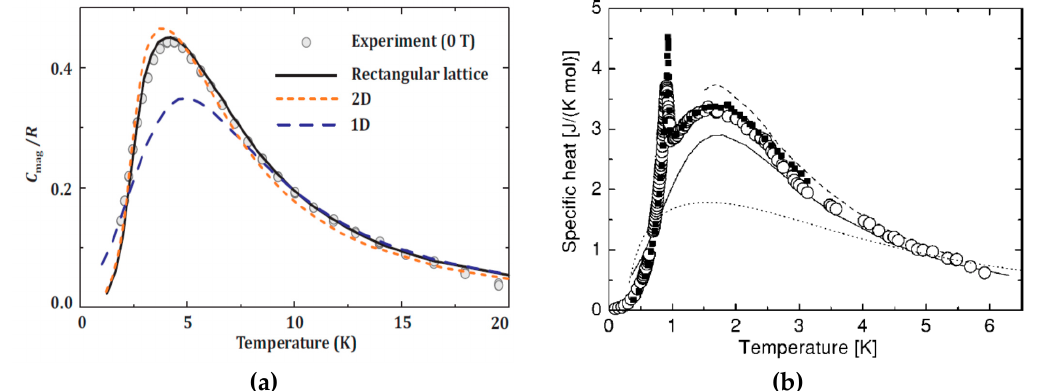
Figure 6. ( a ) Fits of the magnetic specific heat of Cu(PM)(EA) 2 in B = 0 with the model (Equation (4)) for R = 0 (1D), R = 1 (2D) and R = 0.7 (rectangular lattice) with the same parameters as in Figure 5. (Reproduced with permission from reference [79]); ( b ) Fits of the magnetic specific heat of Cu(en)(H 2 O) 2 SO 4 in B = 0 (open and full circles correspond to powder and single crystal, respectively) with the model (Equation (4)) for R = 0 with J / k B = 3.6 K, (solid line), R = 1 with J / k B = 2.8 K (dashed line) and the model of the S = 1/2 HAF on the triangular lattice with J / k B = 4.4 K (dotted line). (Reproduced with permission from reference [65]).